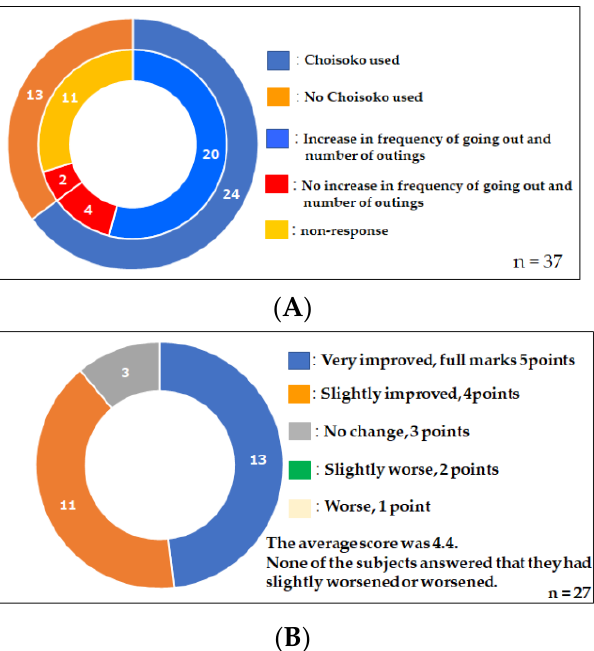
Figure 5. ( A ) Choisoko usage and frequency of going out. The use of Choisoko creates going out. ( B ) Changes in quality of life due to the use of Choisoko. ( B ) Changes in quality of life due to the use of